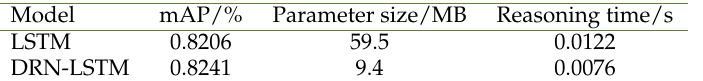
Fig. 4. Structure diagram of improved residual block Table 2. Changes in parameters after